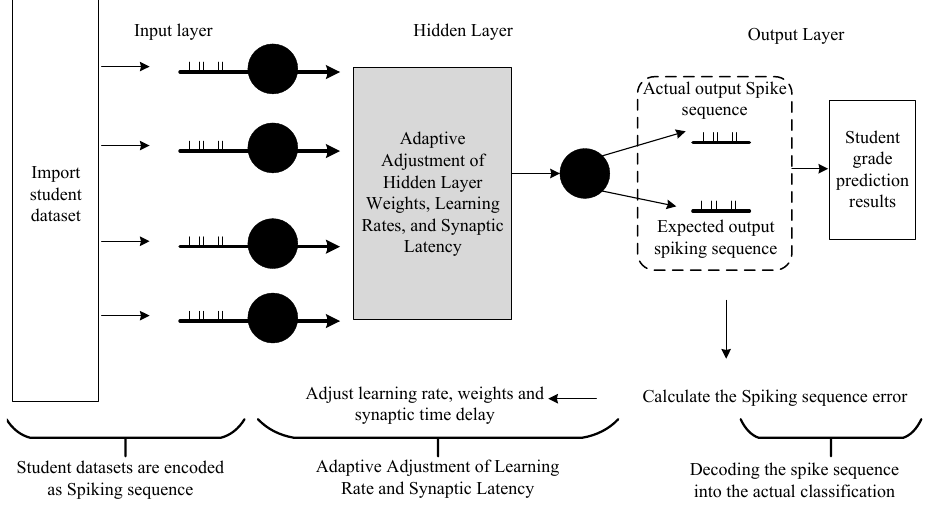
Figure 2. Structure topology of spiking neural network based on student achievement